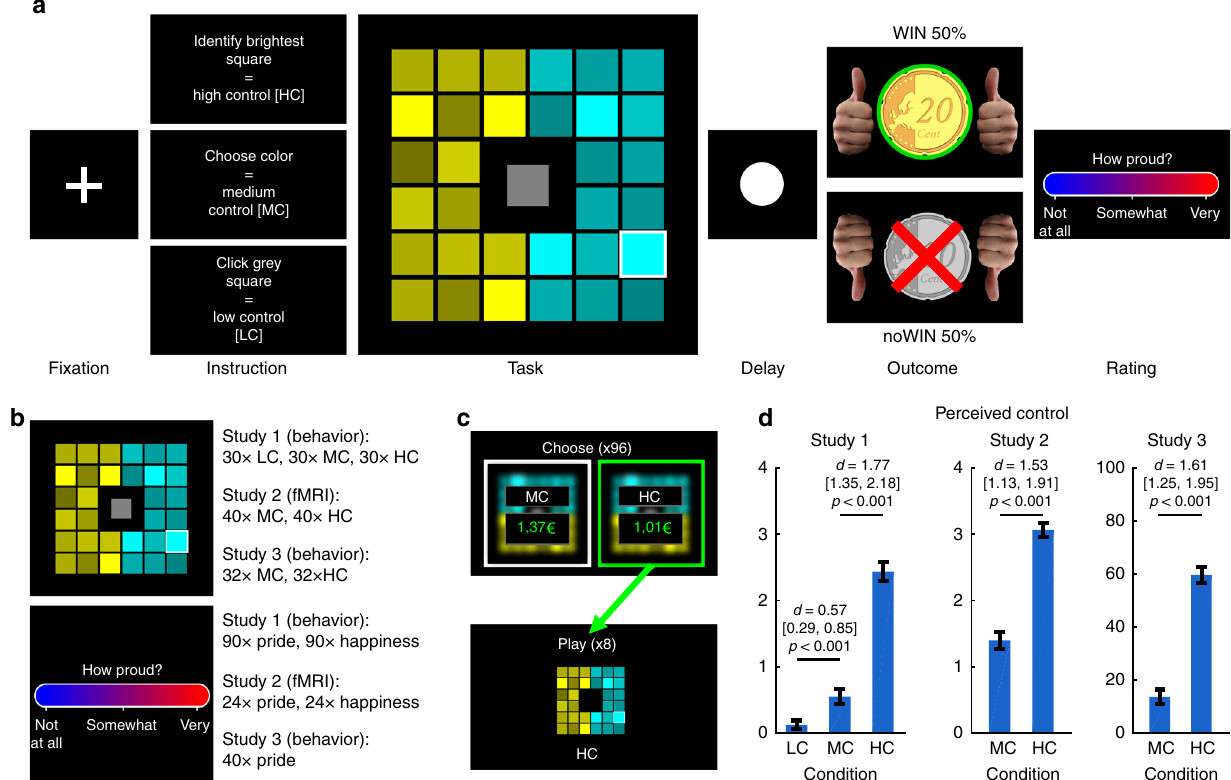
Fig. 1 Overview about the experimental paradigm and the three studies. a Trial structure of the task. A fi xation cross was followed by a cue indicating that the participant has to fi nd the brightest square within either turquoise or yellow (high control, HC), choose between yellow and turquoise (medium control, MC), or play a gamble by clicking on the gray square in the middle (low control, LC; only presented in study 1). After the cue, the task grid occurred, and was followed by a delay and task outcomes. Pride and happiness ratings regarding the preceding outcome were presented after the outcome phase. See “ Methods ” and Supplementary Methods for detailed timing information of the three studies. b Overview of the three studies. The task was presented in each study with varying numbers of trials, conditions, and ratings. In study 1, both pride and happiness were rated after each outcome. In study 2, either pride or happiness were rated after a given outcome. Ratings were evenly distributed across the four possible outcomes, and the order of pride and happiness ratings was prede fi ned and counterbalanced across subjects. In study 3, only pride was rated, and prede fi ned ratings were evenly distributed across all possible outcomes. See “ Methods ” for details. c In study 3, after the main task, 96 trials of a choice task were presented. The choice options offered to play either HC or MC with adaptively changing amounts of money determined using a staircase algorithm. Participants were informed that some of the chosen options would be actually presented, and that the associated monetary gain would be awarded at the end of the experiment. d Internal control belief ratings for each study ( “ How much could you in fl uence the outcome of the task ” ). d = Cohen ’ s d . Values in brackets represent lower and upper bounds of 90% con fi dence intervals. HC high control, MC medium control, LC low control. Error bars are + / − 1 standard error of the mean. Source data are provided as a Source Data fi